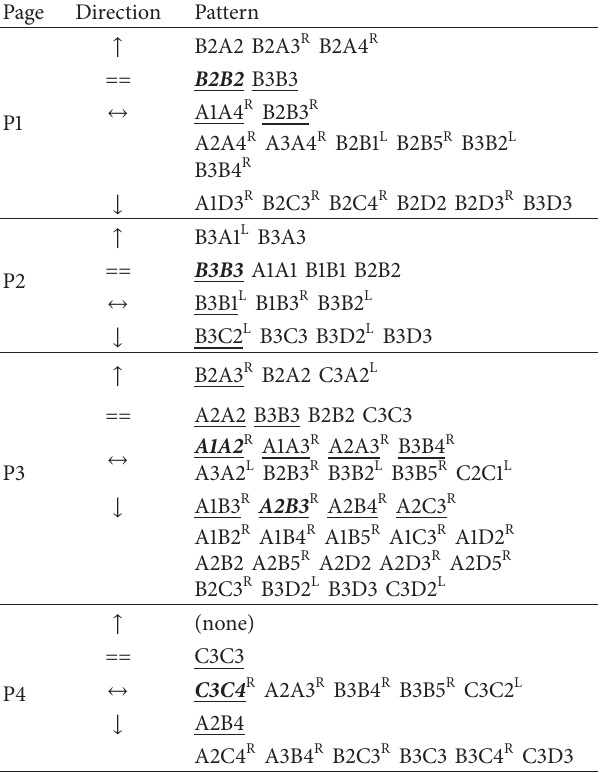
Table 4: Double-chunk patterns by